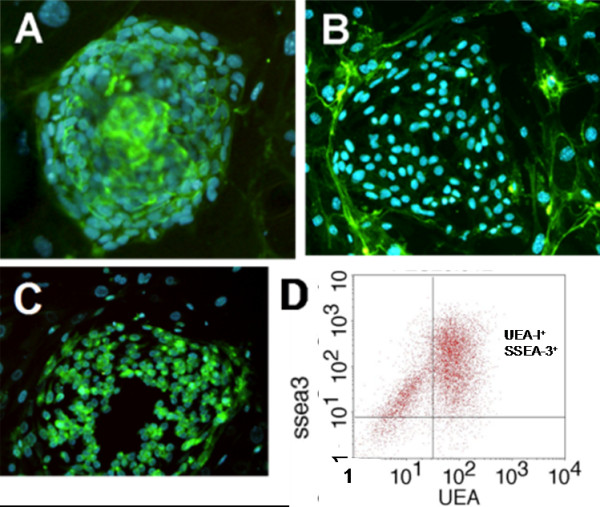
Lectin staining of hESC colonies grown on mouse feeder cell layers. A. Maackia amurensis agglutinin (MAA) that recognizes α2,3-sialylated glycans, preferably in type 2 LacNAc, stained hESC but not feeder cell surfaces. B. Pisum sativum agglutinin (PSA) that recognizes α-mannosylated glycans and core fucosylated N-glycans, stained only mouse feeder cell surfaces. C. Ulex europaeus agglutinin I (UEA-I) that recognizes α1,2-fucosylated glycans preferably within H type 2, stained the hESC colony. Mouse fibroblasts had complementary staining patterns with the lectins, indicating that their surface glycans are clearly different from hESC. D. Fluorescence-assisted cell sorting (FACS) diagrams of UEA-I selected hESC, showing that the majority of hESC were positive for cell surface UEA-I ligands.